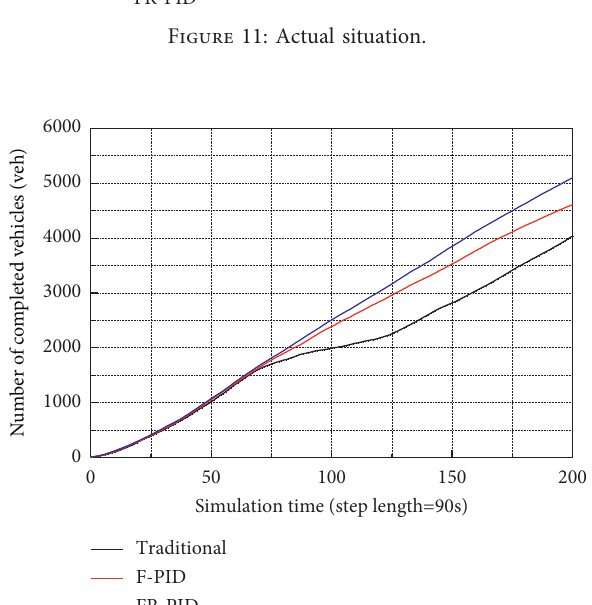
Figure 12: Accumulative completed volume in the controlled area.